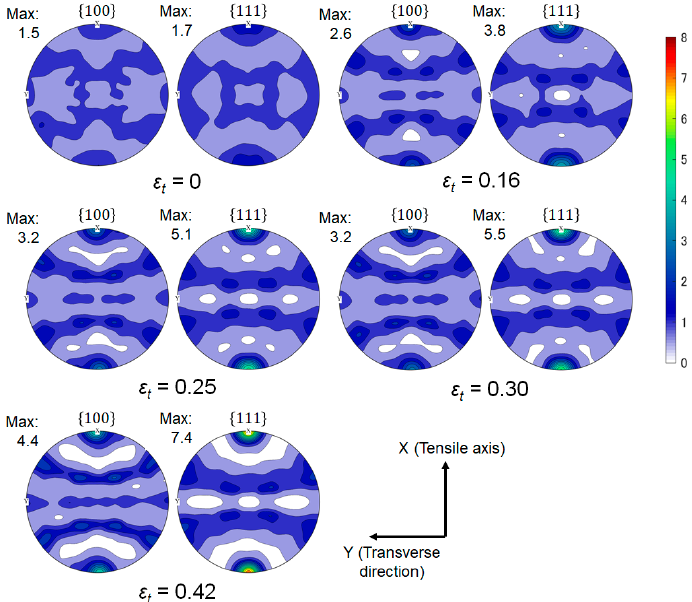
Figure 1. Analyzed {001} and {111} pole figures of the γ phase at various true strains ( ε t ). The contour step was 0.5.